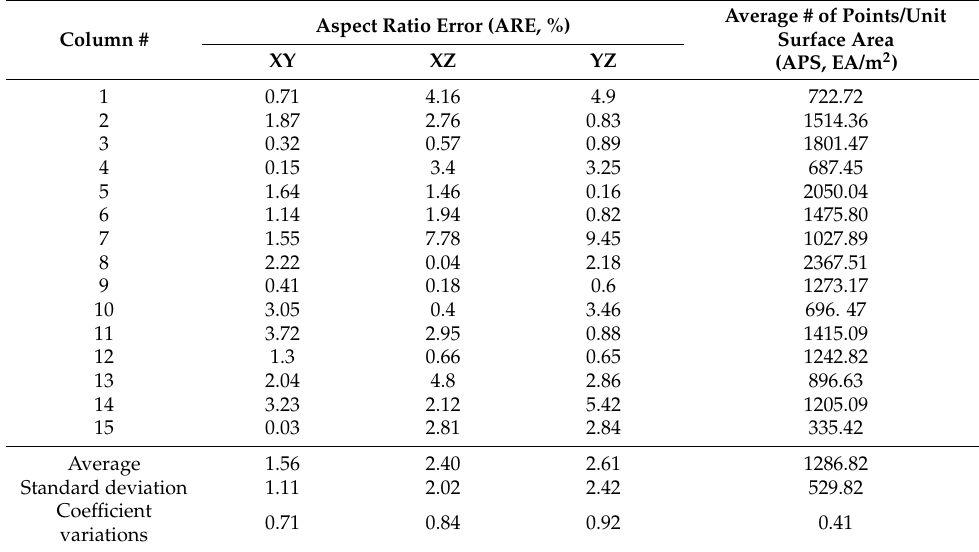
Figure 7. Reconstructed 3D point cloud of 15 concrete columns. Table 4. Shape accuracy and point density of 15 reconstructed concrete